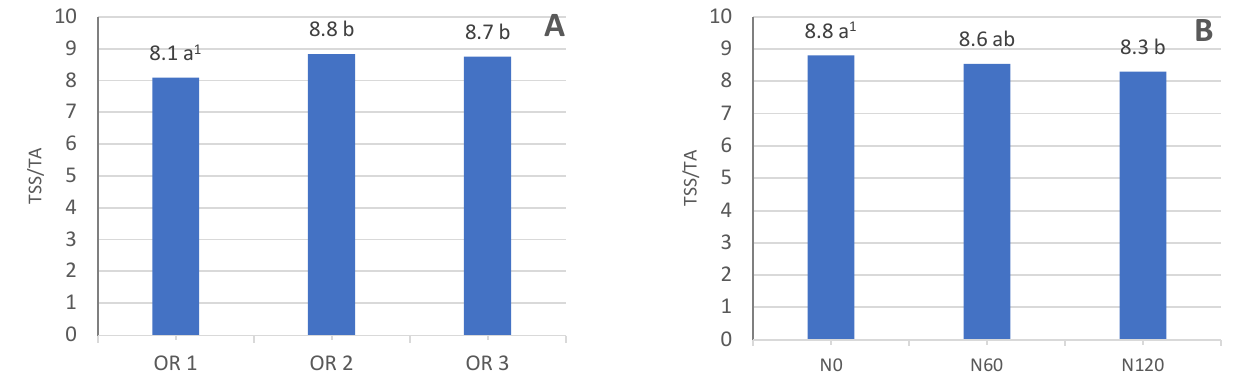
Figure 3. Ratio of total soluble solid content (TSS) and acidity (TA) depending on the age of the orchard ( A ) and nitrogen fertilization ( B ). 1 means that the same letters are not significantly different at α = 0.05 (Duncan’s test).